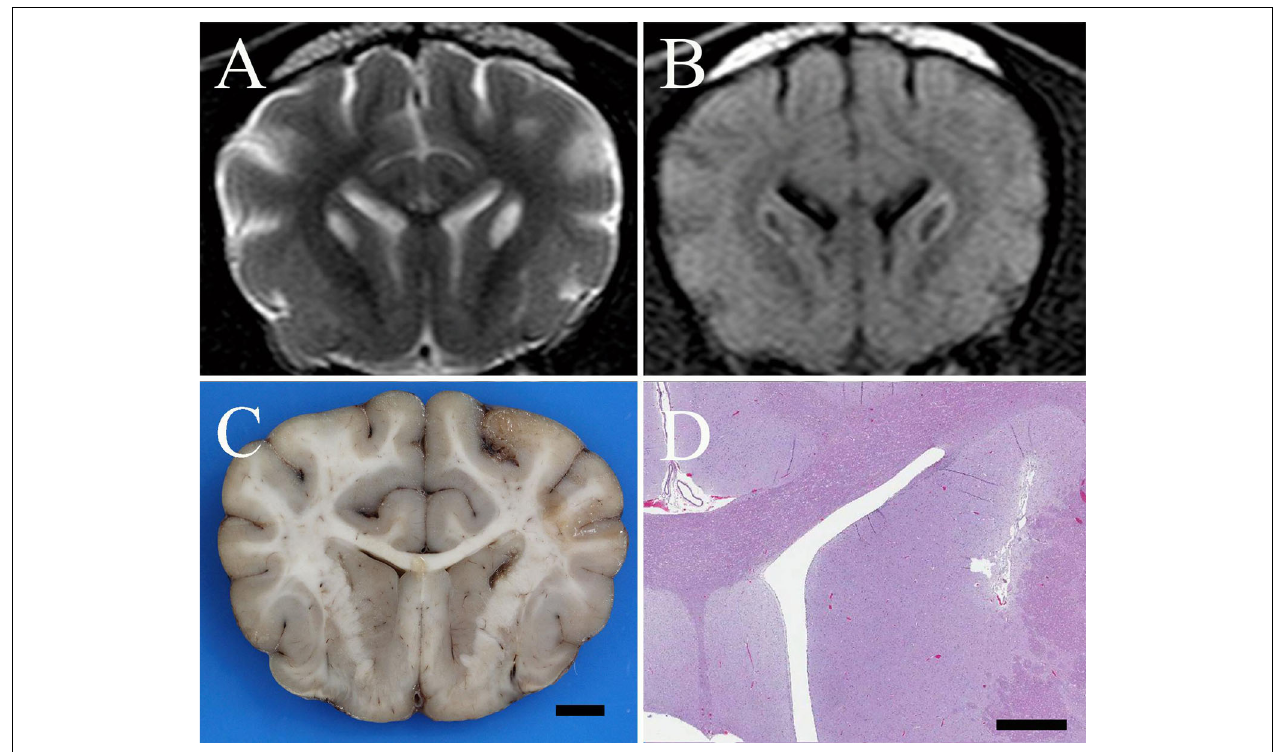
FIGURE 1 | (A) Transverse T2-weighted turbo spin echo MR image of a 1-year-old spayed female Shih Tzu presenting for episodic multifocal encephalopathy. There are bilaterally symmetric, teardrop-shaped hyperintensities of the caudate nuclei suggestive of a metabolic encephalopathy. (B) Transverse FLAIR MR image at the same level as in (A) reveals the caudate nuclear lesions are hypointense with hyperintense rims. This suggests a low-protein cavitated lesion within the caudate nuclei surrounded by either edema, proteinaceous fluid, inflammation, or, less likely, neoplastic tissue. (C) Formalin fixed brain, dog. Photograph of a transverse section of the cerebrum at the level of the caudate nuclei. There are bilateral, linear cavitated foci of necrosis within the caudate nuclei adjacent to the internal capsule; bar = 5mm. (D) Brain, dog. Photomicrograph at the same level as (C) . Bilateral, linear, cavitated foci of necrosis are present adjacent to the internal capsule. H&E stain; Subgross Image, bar = 1.5mm.